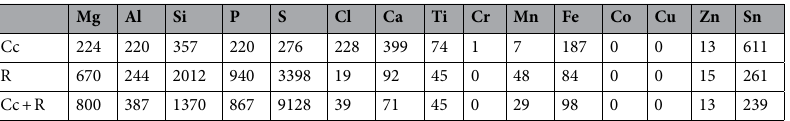
Table 8. Average concentration of elements in corn cobs, rice husks, and corn cobs + rice husks mixed biomass. Cc—Corn cobs. R—Rice husks. Cc + R—Corn cobs + Rice husks mixed